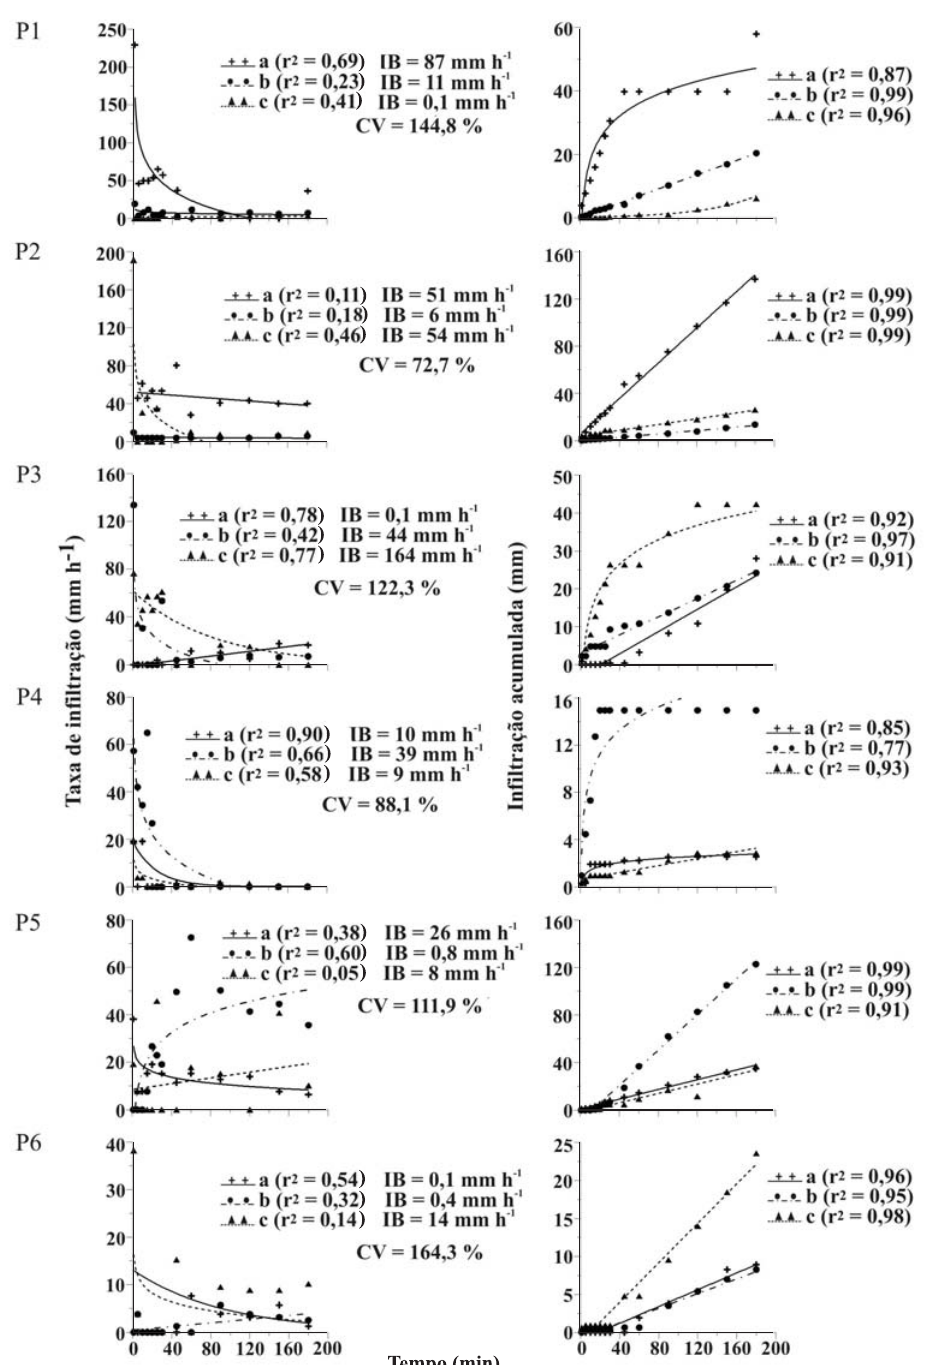
Figura 2. Taxa de infiltração, infiltração acumulada e IB de água dos Neossolos Litólicos e Neossolos Regolíticos derivados de arenito da Formação Caturrita. As letras a, b e c representam as três repetições realizadas em cada perfil (P1 a P6). CV = coeficiente de